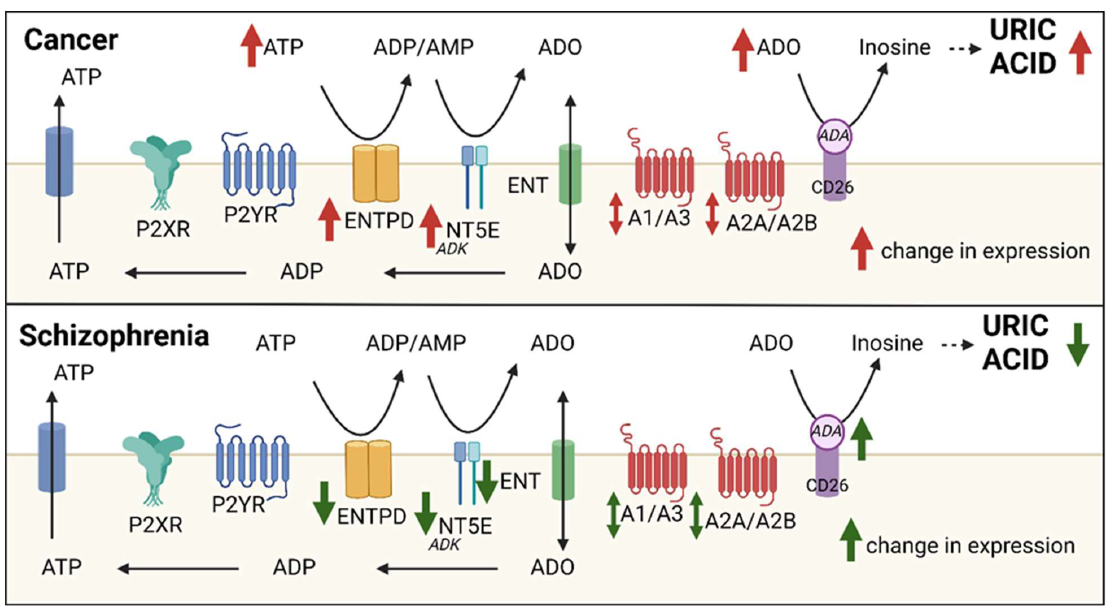
Figure 2. ATP and adenosine metabolism and signaling in cancer and schizophrenia. Perturbations in extracellular adenosine generating pathways are implicated in schizophrenia (green arrows) and cancer (red arrows). Differential purinergic (P1 and P2 receptors) receptor expression is reported in schizophrenia and cancer. ADA adenosine deaminase, ADK adenosine kinase, ADO adenosine, ATP adenosine triphosphate, ADP adenosine diphosphate AMP adenosine monophosphate, ENTPD ectonucleoside triphosphate diphosphohydrolases, NT5E ecto-5′nucleotidase. Generated in Biorender. Table 2. Nomenclature of ENTPD family enzymes.